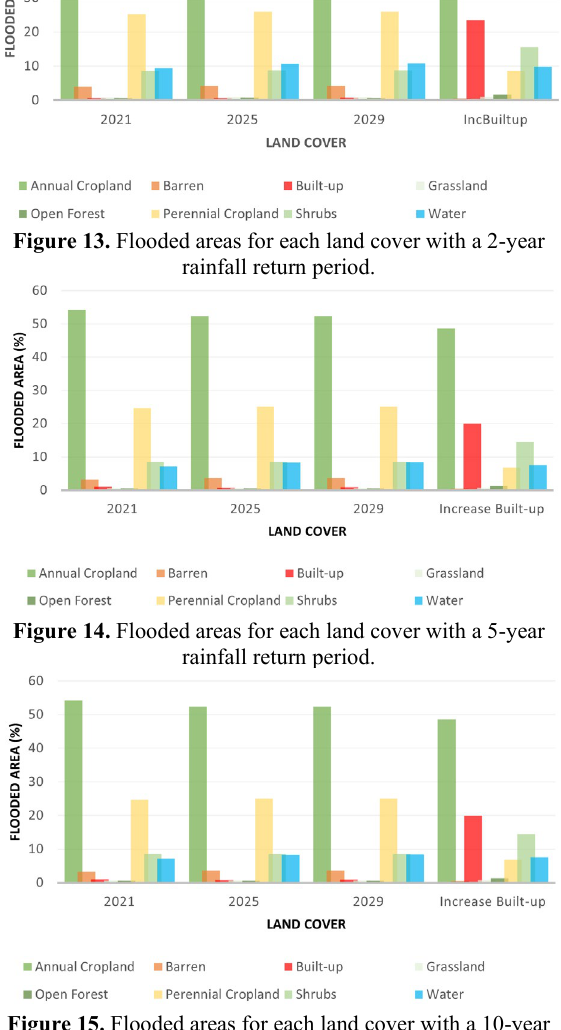
Figure 15. Flooded areas for each land cover with a 10-year rainfall return